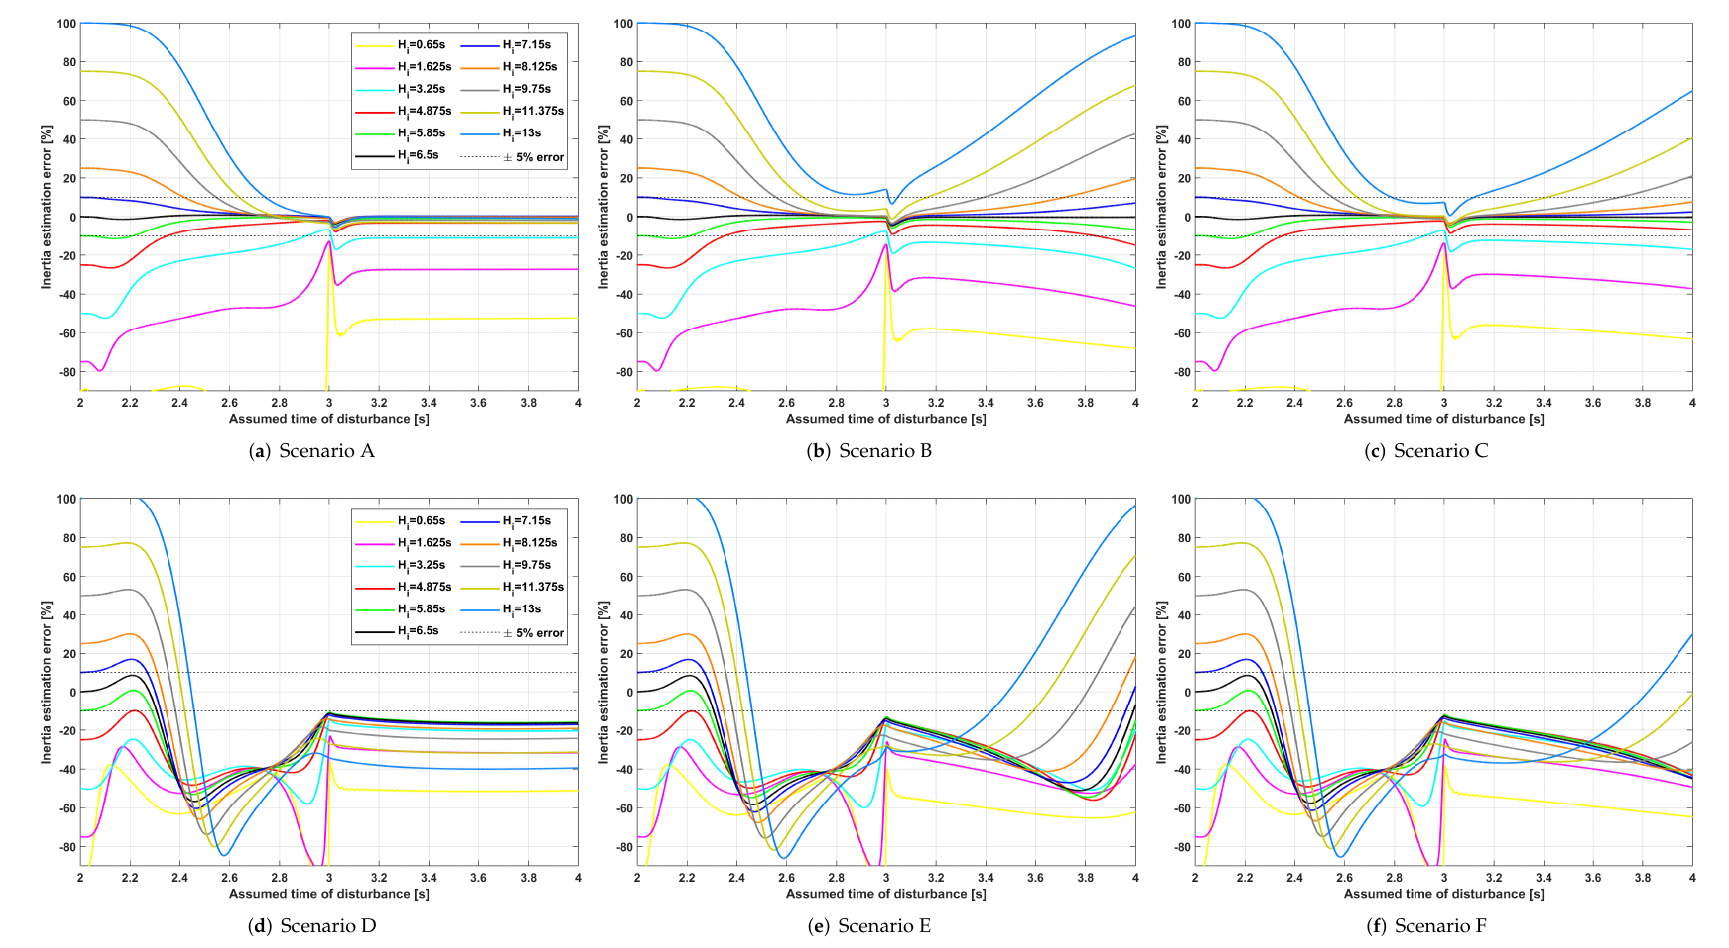
Figure 7. Analysis of the EKF-based inertia estimates to the assumed time of disturbance ( t dur = 1s). The colored curves in each plot refer to the same legend. For the sake of clarity, the legend is only included in the plots where it does not overlap with the